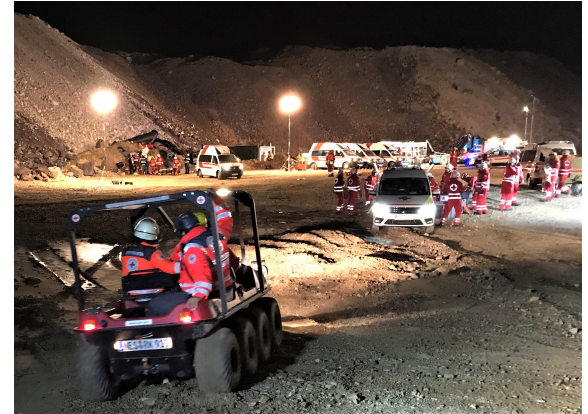
Figure 1. Rescue operations at a simulated landslide during the IRONORE2019 exercise (source: